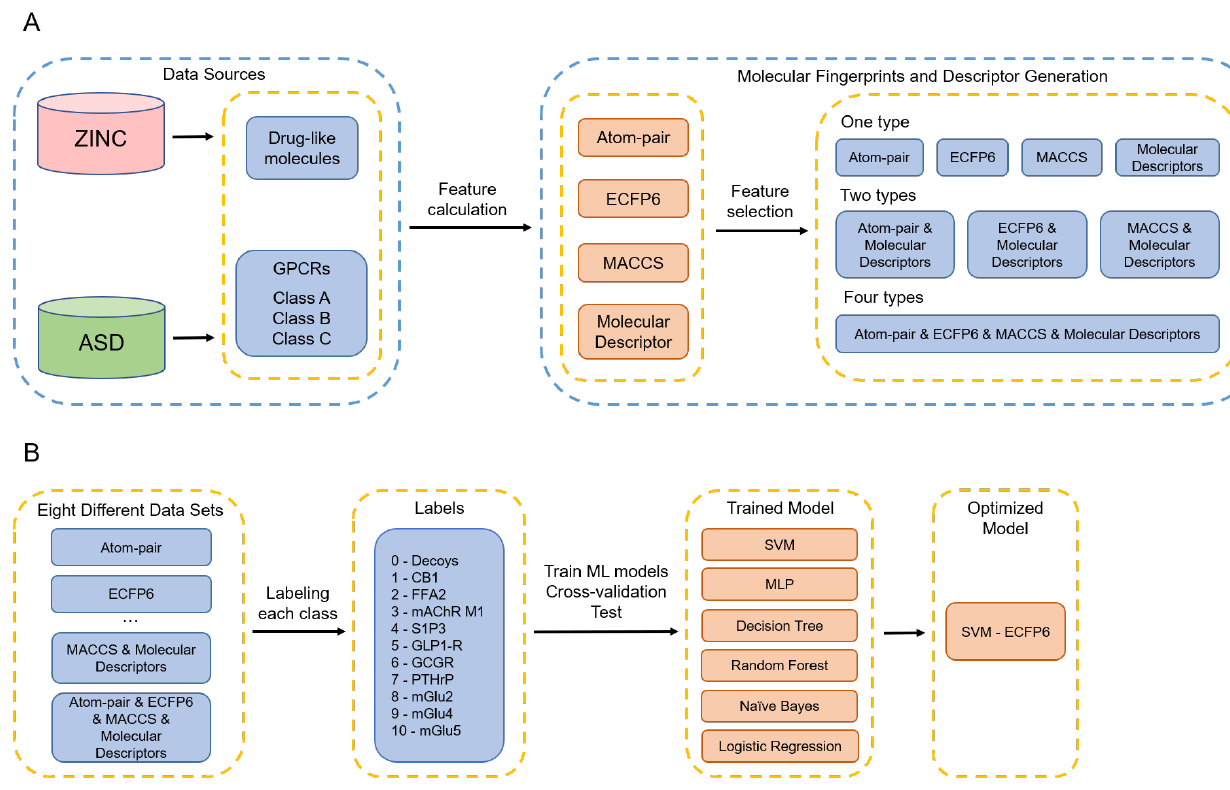
Figure 1. Schematic illustration of the workflow. ( A ) Workflow of data collection and reconstruction. ( B ) Workflow of model training and validation. GPCRs abbreviations: Cannabinoid receptor 1 (CB1); Free fatty acid receptor 2 (FFA2); Muscarinic acetylcholine receptor M1 (mAchR M1); Sphingosine 1-phosphate receptor 3 (S1P3); Glucagon-like peptide 1 receptor (GLP1-R); Glucagon receptor (GCGR); Parathyroid hormone-related peptide receptor (PTHrP); Metabotropic glutamate receptor 2 (mGlu2); Metabotropic glutamate receptor 4 (mGlu4); Metabotropic glutamate receptor 5 (mGlu5).